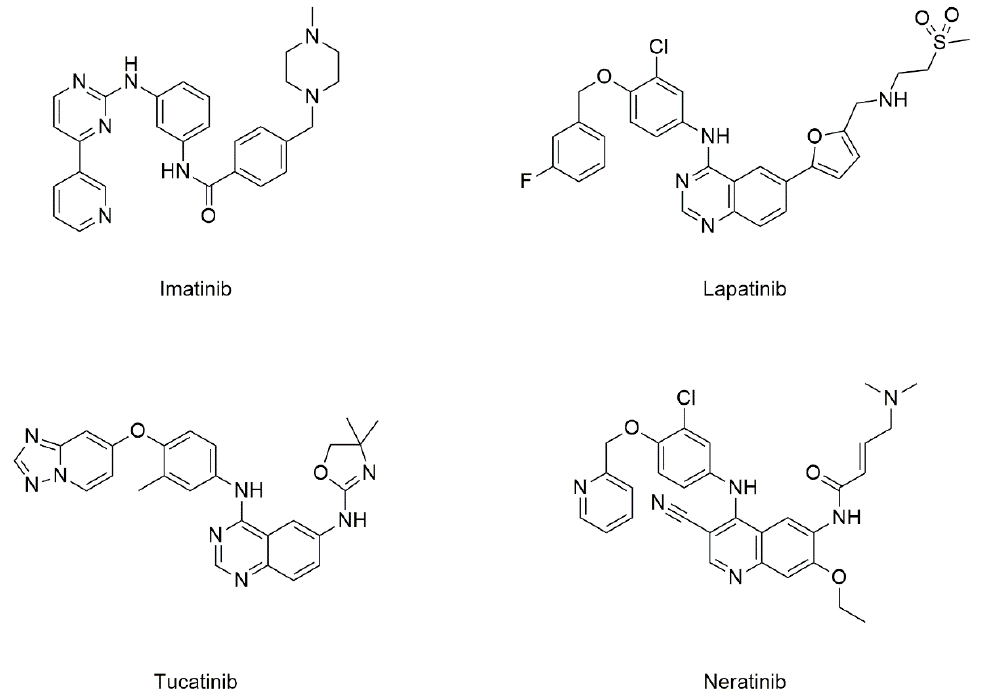
Figure 4. Chemical structures of imatinib, lapatinib, neratinib, and tucatinib.